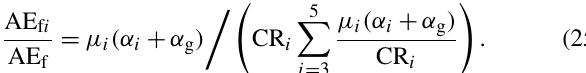
a The values were estimated from experiments by Mathews and Fisher (2008). b The value was estimated using BAF from IAEA (2004). c Heling and Bezhenar (2009) for seawater environment.